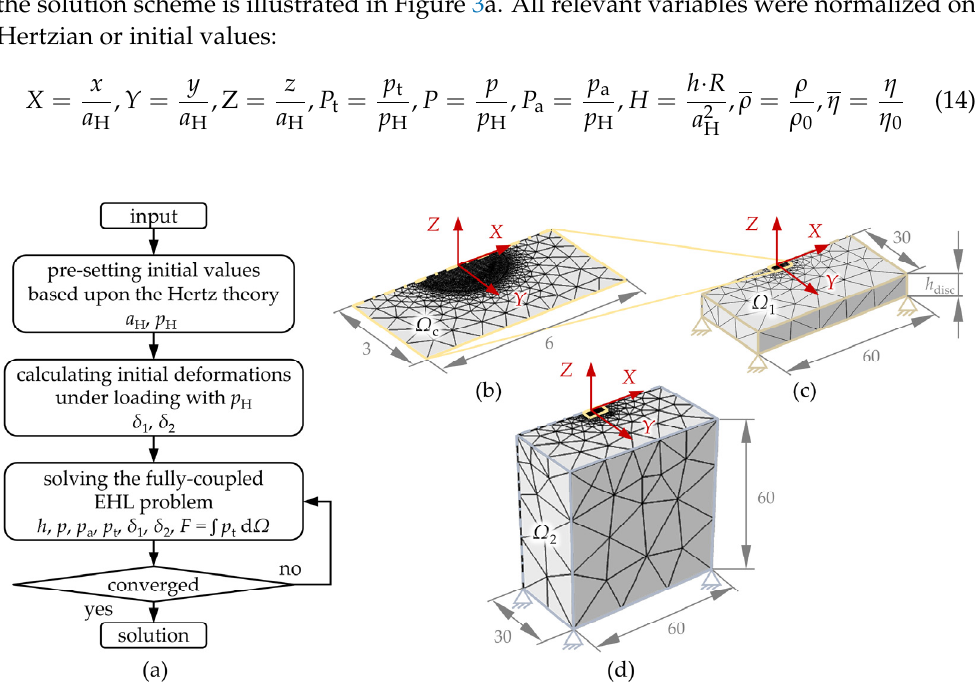
Figure 3. Numerical solution scheme ( a ) and computational domains with meshing and boundary conditions ( b – d ).